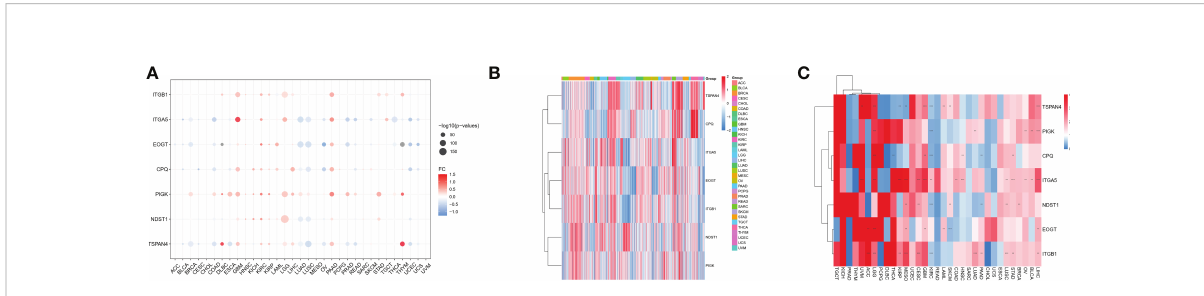
FIGURE 1 Differential expression of MRGs in pan-cancer correlates with prognosis. (A) Differential expression of MRGs in solid tumors in The Cancer Genome Atlas cohort pan-cancer data. Expression analysis was based on the comparison of TCGA tumors with TCGA paracancerous and GTEx normal. (B) Expression of the seven MRGs in different cancers. The -2 to 2 values of the color bar in the fi gure represent the gene expression values after homogenization. (C) The relationship between MRGs and cancer prognosis in different cancers. the 0-4 values of the color bar in the fi gure represent the hazard ratio. **P < 0.01, and ***P < 0.001. FC, Fold